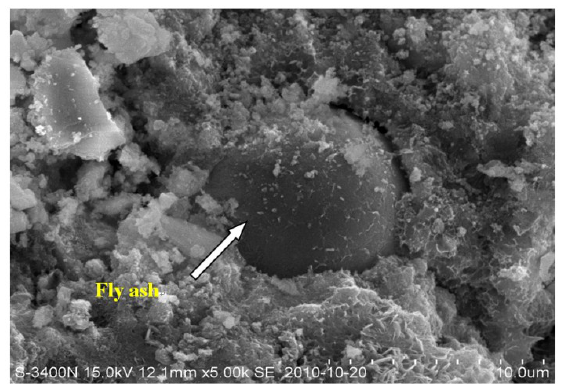
Figure 5. Scanning electron microscopy (SEM) picture of fly ash concrete M1.